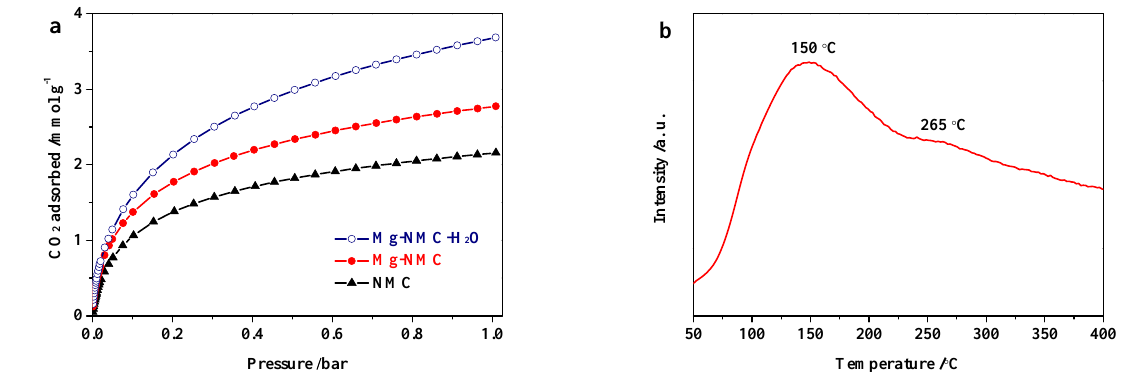
Figure 6. ( a ) CO 2 adsorption isotherms for NMC, Mg-NMC and Mg-NMC-H 2 O at 273 K; ( b ) CO 2 -TPD profile of